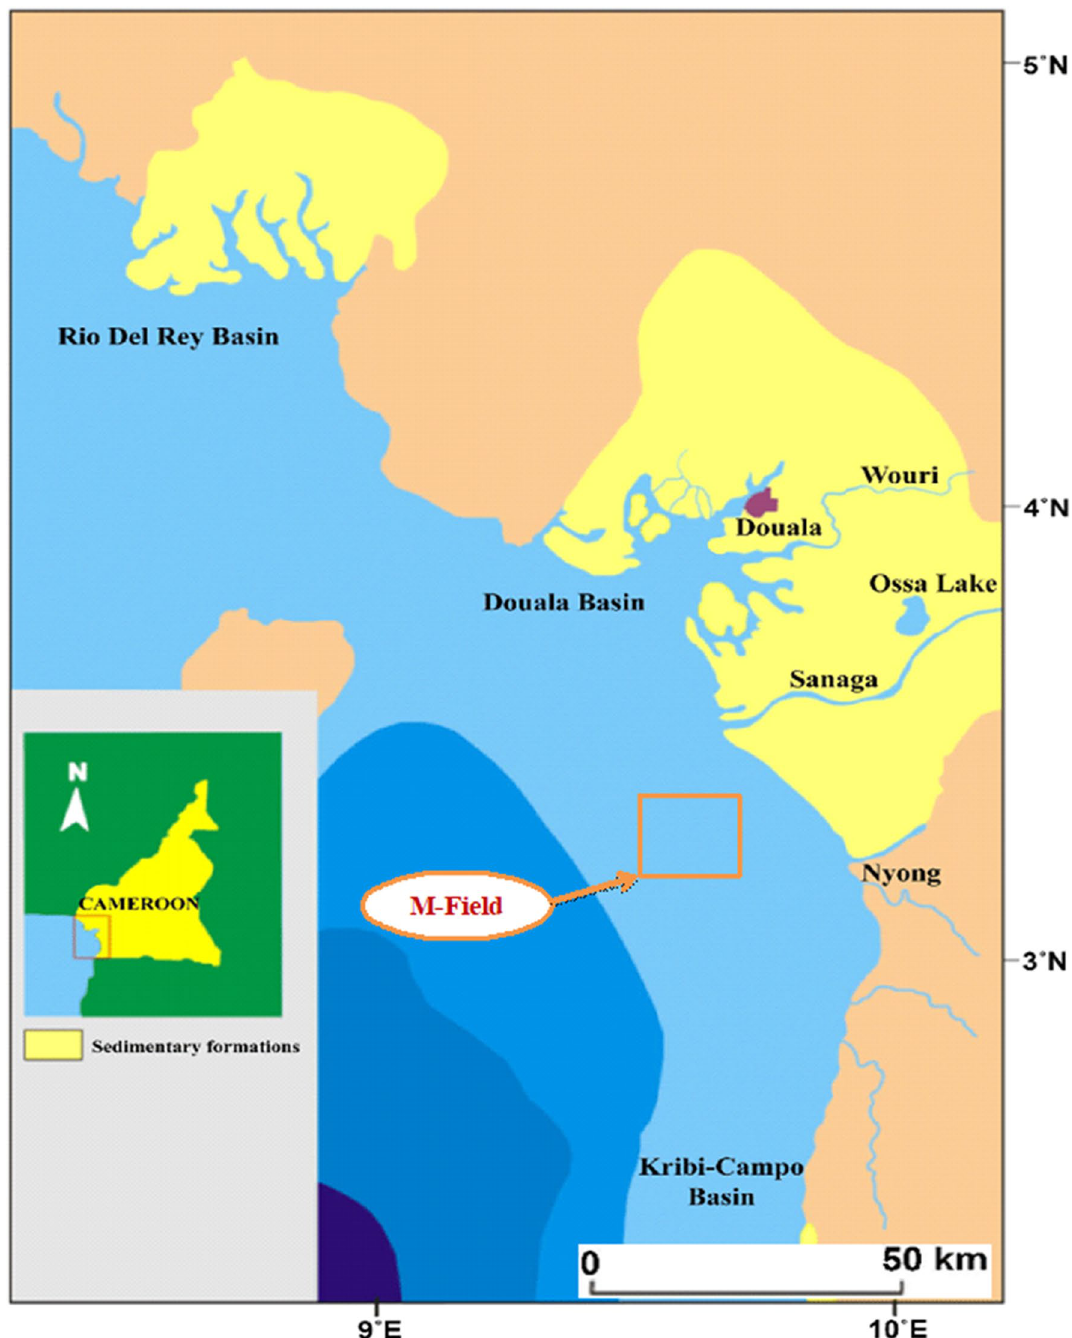
Fig. 1 Location map of the study